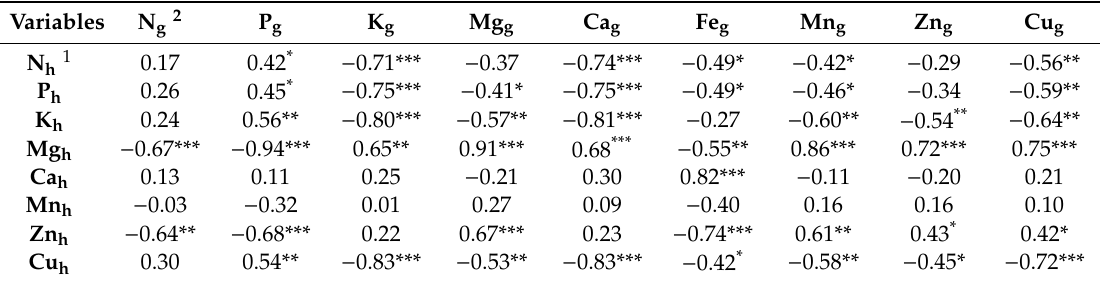
Table 7. Relationships between the contents of nutrients in leaves of spelt wheat at heading and in the grain at maturity, n =